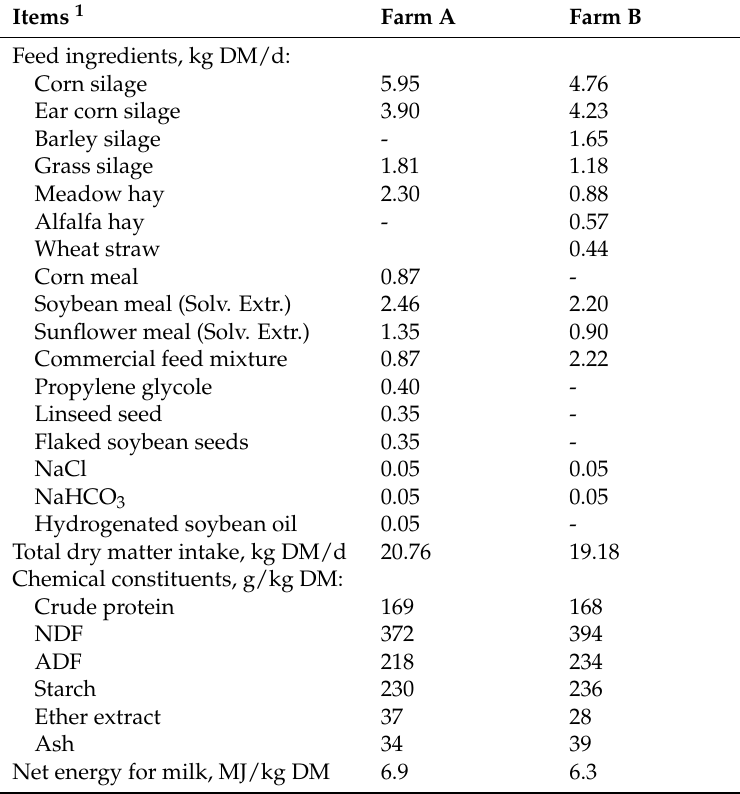
Table 1. Characteristics of the rations used in the two